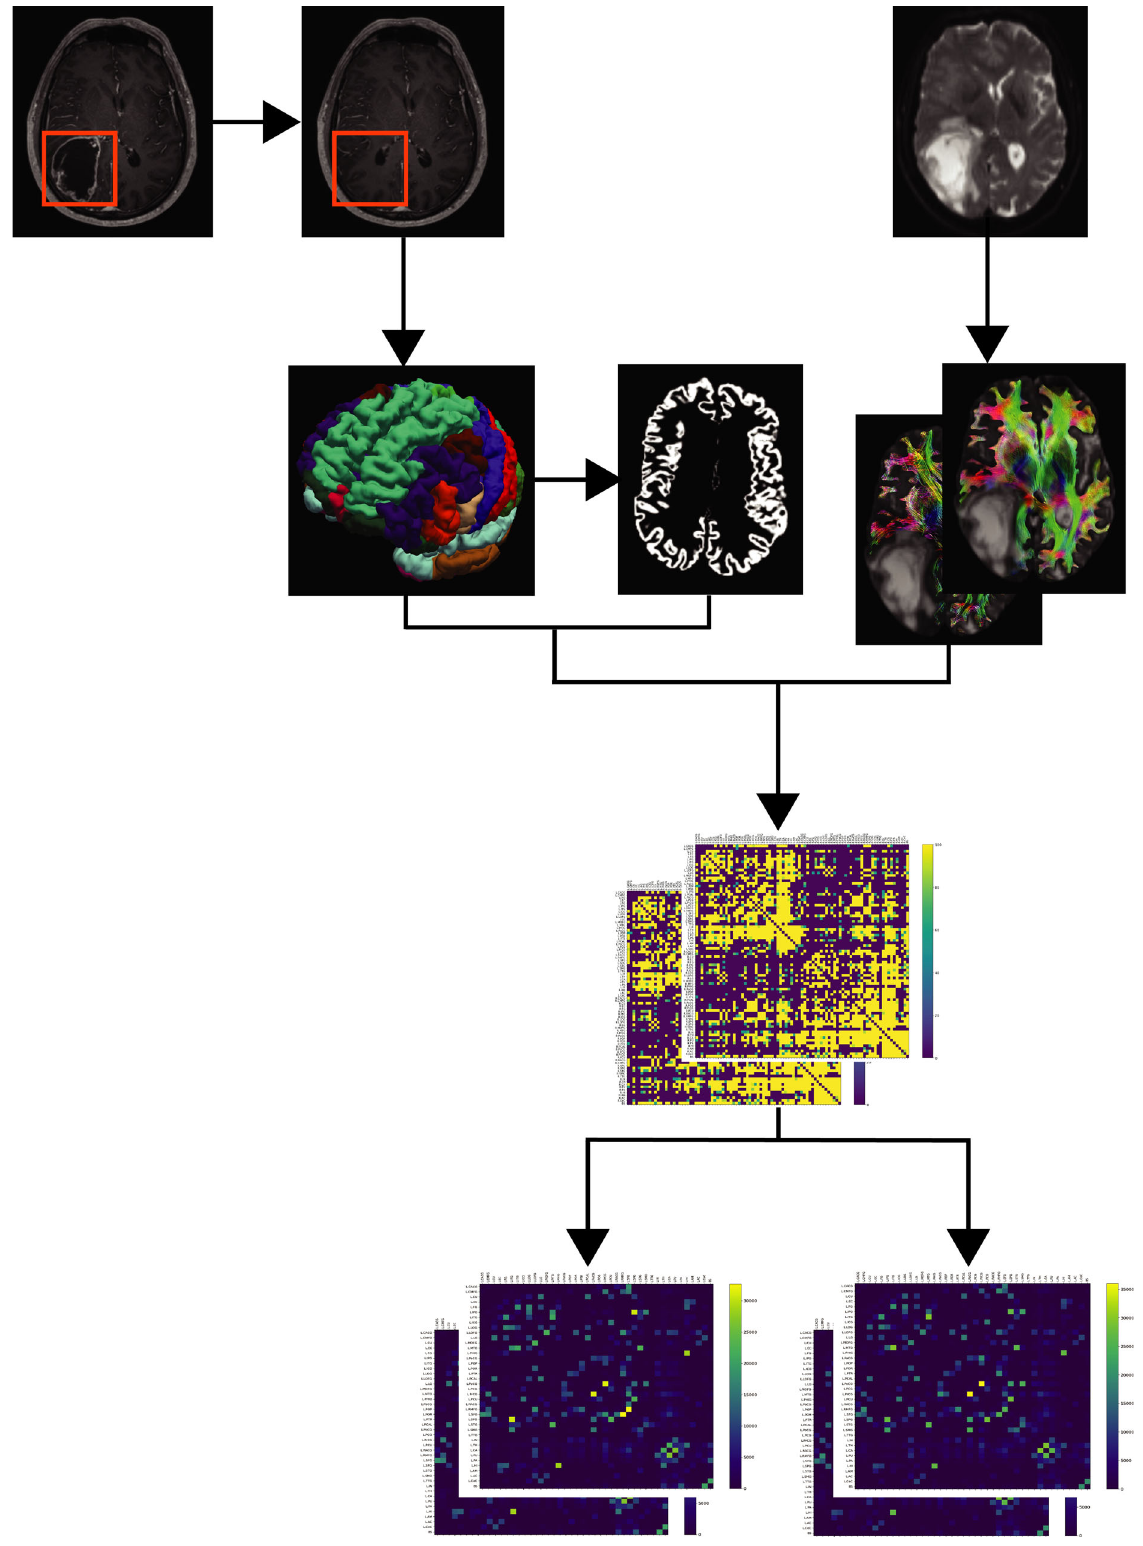
Fig. 6 Network reconstruction work fl ow. Tumors were masked and used for enantiomorphic fi lling of the T1-weighted structural images, which were then processed by the FastSurfer pipeline to obtain subject-speci fi c parcellations and surface reconstructions. After whole brain tractography within the ACT framework of 50,000,000 streamlines per subject, tractograms were fi ltered to 10,000,000 streamlines per subject. Further, symmetric connectome matrices were generated and separated into contra- and ipsilesional